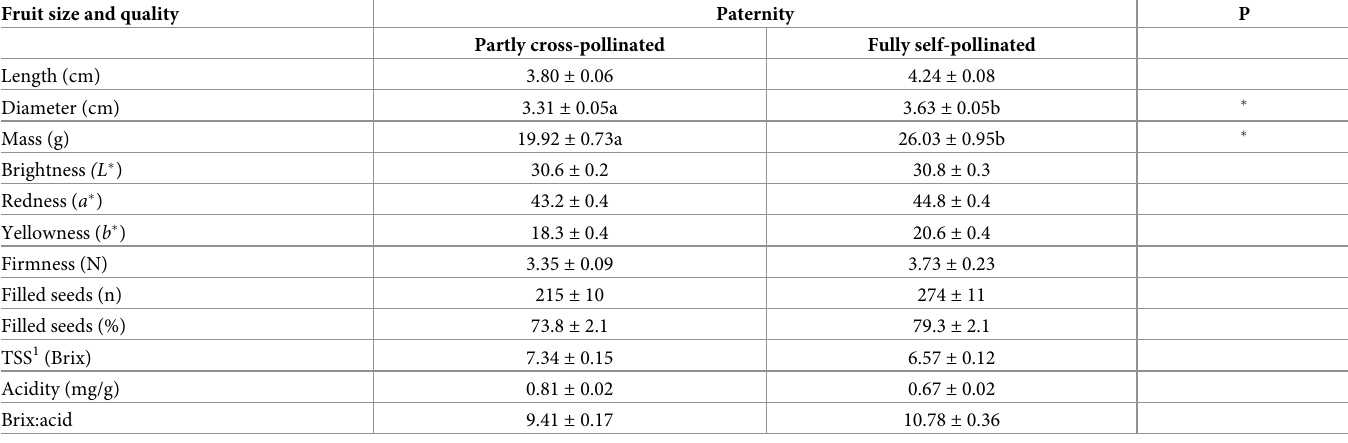
Table 4. Size and quality of partly cross-pollinated and fully self-pollinated fruit of Sundrench strawberry. Fruit size and quality